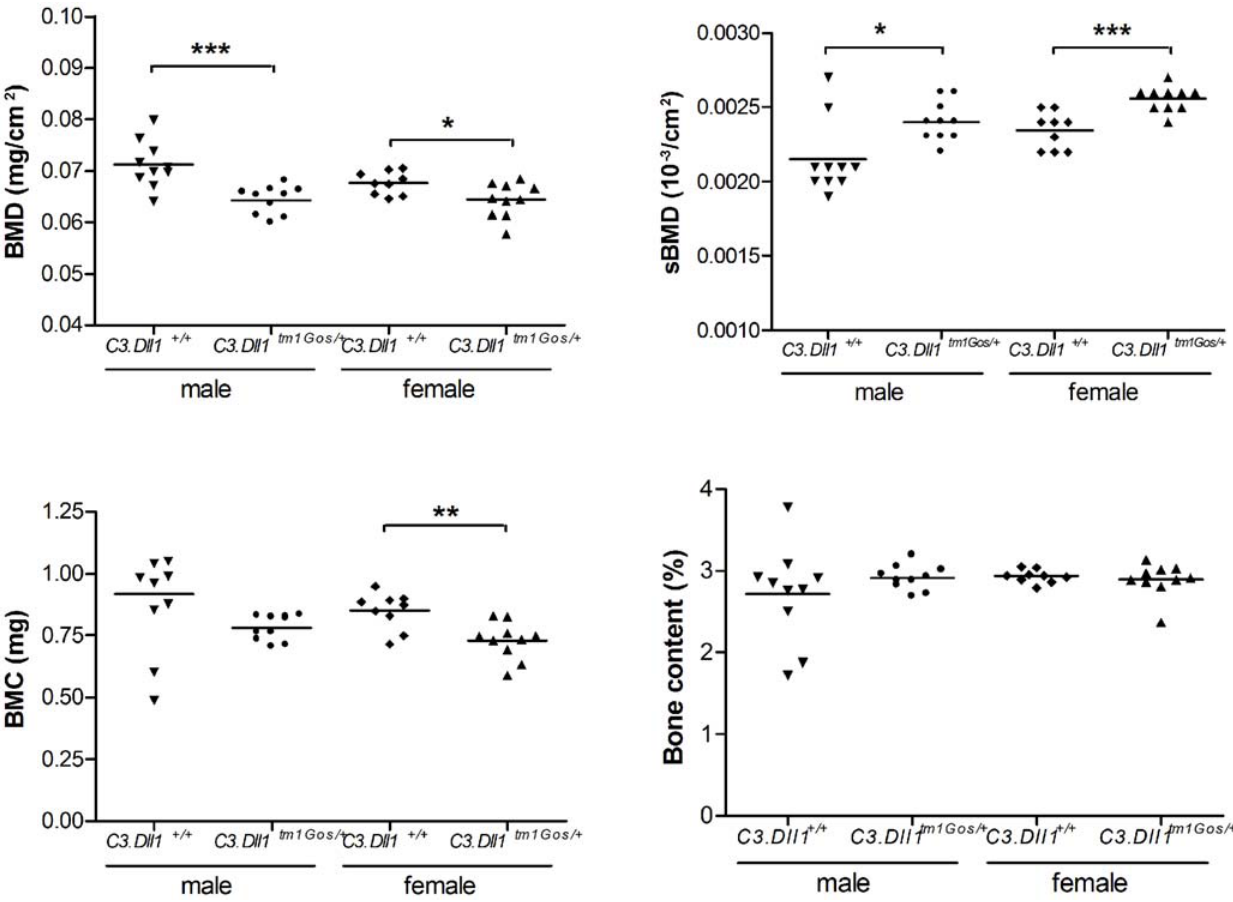
Figure 5. Selected bone parameters obtained with a Dual energy X-ray absorptiometer from heterozygous C3.Dll1 tm1Gos/ + animals. A–D) Depicted are the scatter dot plot representations and the mean for each group: heterozygous C3.Dll1 tm1Gos/ + males (n=10) and their wild-type littermates ( C3.Dll1 + / + , n=10); heterozygous C3.Dll1 tm1Gos/ + females (n=9) and their wild-type littermates ( C3.Dll1 + / + , n=10). P -values calculated performing unpaired t-test when variances were not significantly different. If significantly different then the Mann-Whitney test was performed. P -value: * P , 0.05, ** P , 0.01, *** P , 0.001.